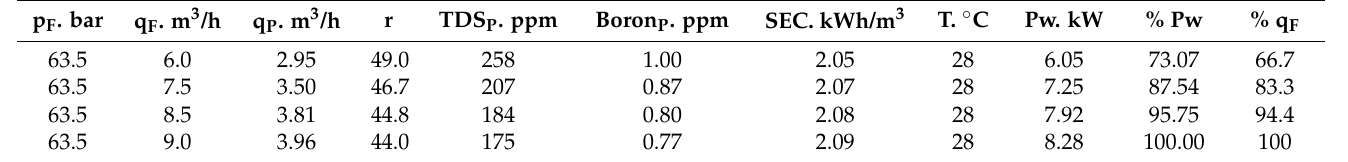
Table 1. Working conditions of a single pressure vessel with seven LG SW 440 SR membrane elements operated at a constant pressure under Mediterranean conditions at an unfavorable temperature.